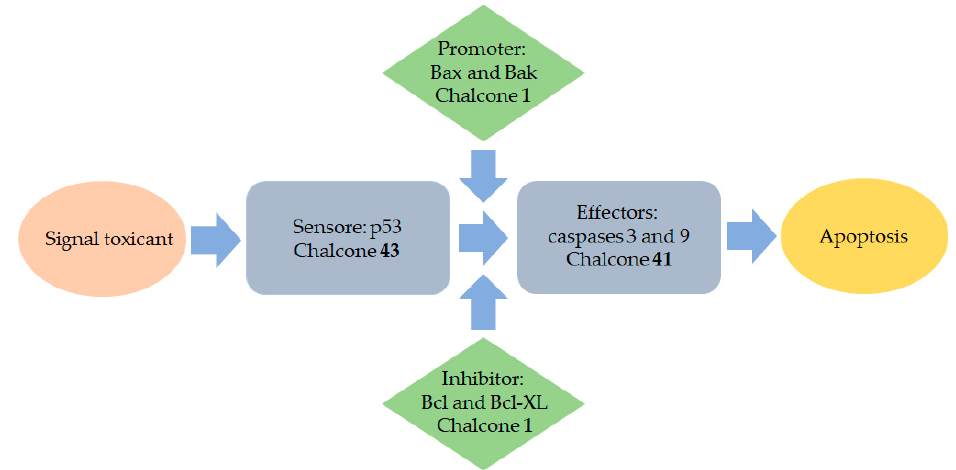
Figure 7. Schematic diagram showing how chalcones induce apoptosis. Figure 7. Structures of some chalcones that interfere with the cell cycle.